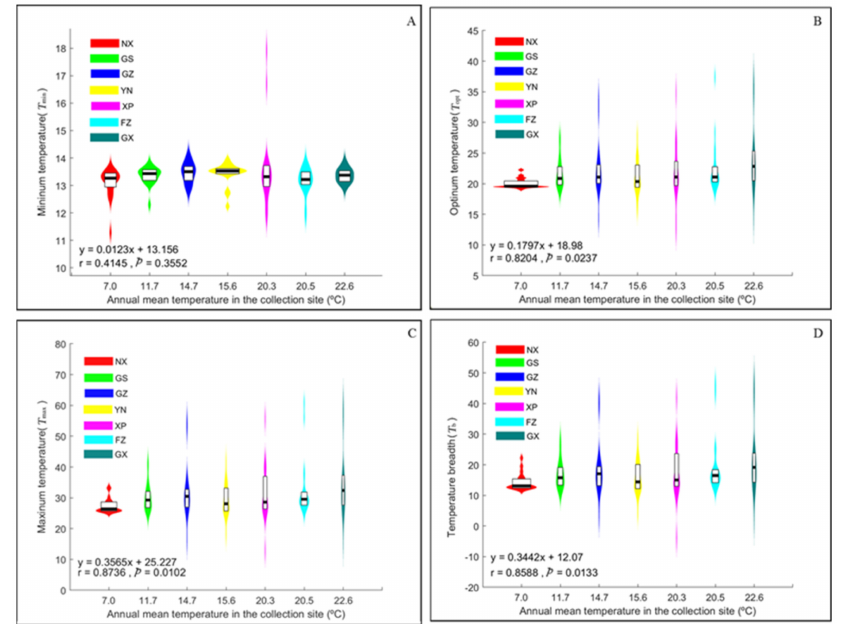
Figure 2. Influence of annual mean temperature at the collection site on the thermal preference of Phytophthora infestans aggressiveness. The thermal preference of aggressiveness of each isolate was estimated from the fitted thermal reaction norm. ( A ) Maximum temperature; ( B ) optimum temperature; ( C ) minimum temperature; and ( D ) temperature